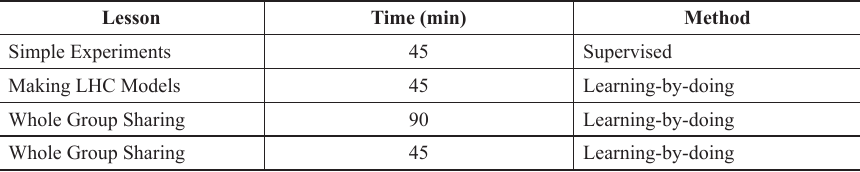
Table 4. “Particle Accelerators and Detectors” lab timeline at school